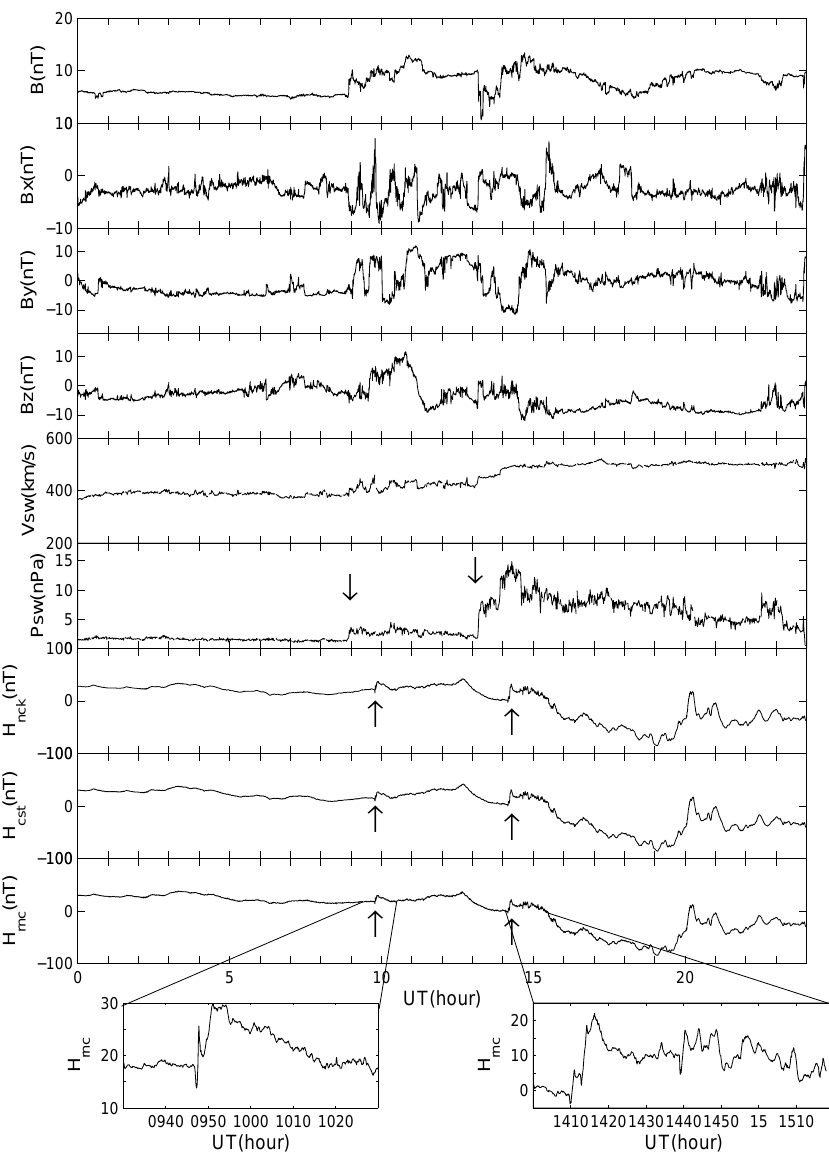
Fig. 3. ACE measurements and ground observations on 3 April 2004. From top to bottom are shown the IMF strength and its components in GSE coordinates, the SW speed and dynamic pressure, the H component at the SEGMA stations NCK, CST and RNC (data are not available at AQU during this day). Details of the two SIs observed at RNC are shown in the two bottom